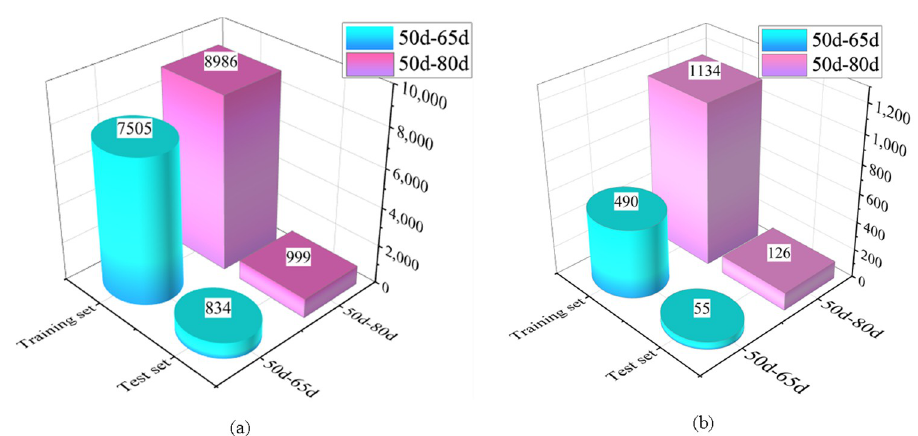
Fig 9. Data sets of the model (a) mRNA; (b)